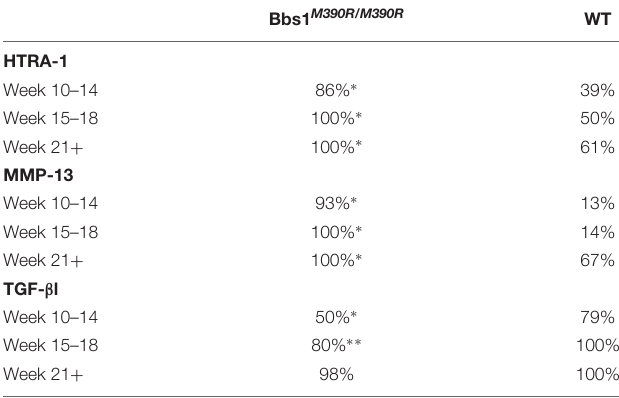
TABLE 1 | Percent Bbs1 M390R/M390R mutant cells stained with biomarkers compared with